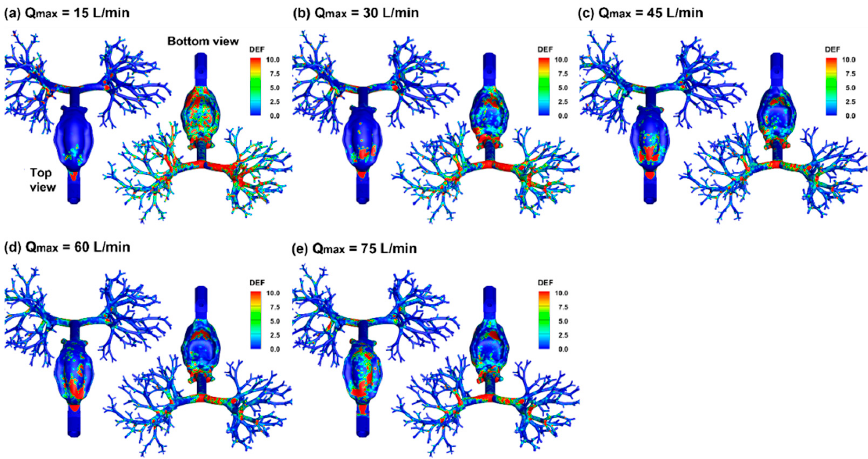
Figure 14. Comparison of the local dosimetry (DEF: deposition enhancement factor) among varying breath depths (Q max ): ( a ) 15L/min, ( b ) 30 L/min, ( c ) 45 L/min, ( d ) 60 L/min, and ( e ) 75 L/min.